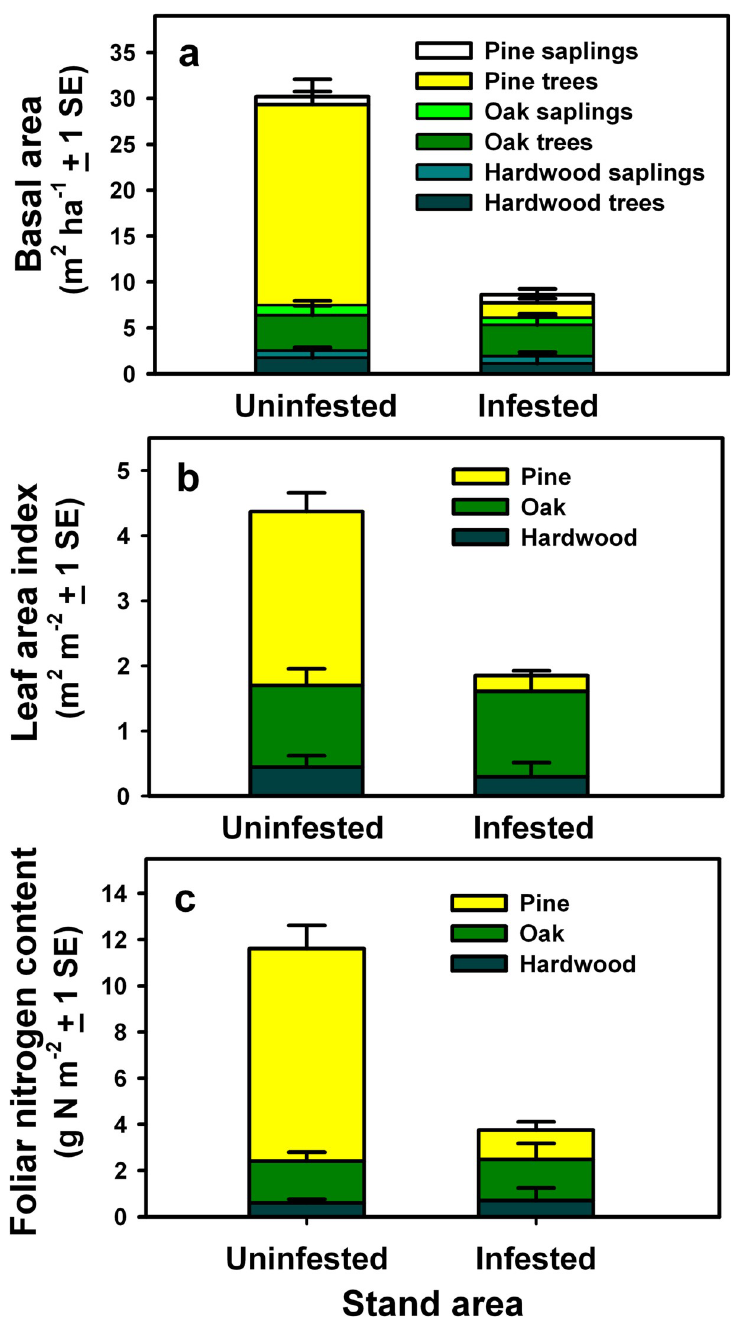
Fig 3. Effects of southern pine beetle on forest composition and structure. (A) Basal area of pine, oak and other hardwood trees and saplings, (B) maximum leaf area of pines, oaks, and other hardwoods during the growing season, and (C) maximum foliar N content of pines, oaks, and other hardwoods during the growing season in uninfested areas and areas following infestation of southern pine beetle in southern New Jersey. Other hardwoods include red maple ( Acer rubrum L.), black gum ( Nyssa sylvatica Marshall), sassafras ( Sassafras albidum (Nutt.) Nees), sweet gum ( Liquidambar styraciflua L.), and sweetbay magnolia ( Magnolia virginiana L.).